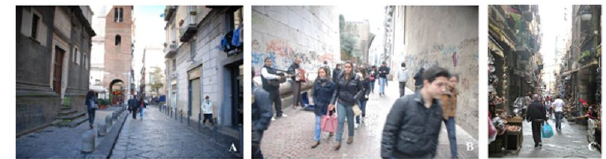
Figure 2: Examples of streets in the historic centre of Naples: ‘Tri- bunali’ (A), ‘S.Biagio’ (B) and ‘S.Gregorio’